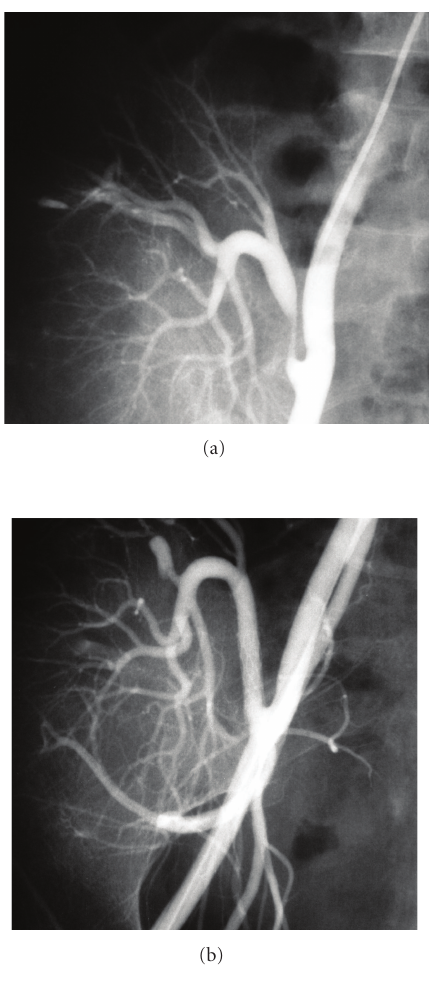
Figure 3: (a) Transplant renal artery stenosis and postbiopsy arteri- ovenous fistula. (b) Postpercutaneous transluminal angioplasty and stenting and post-embolization